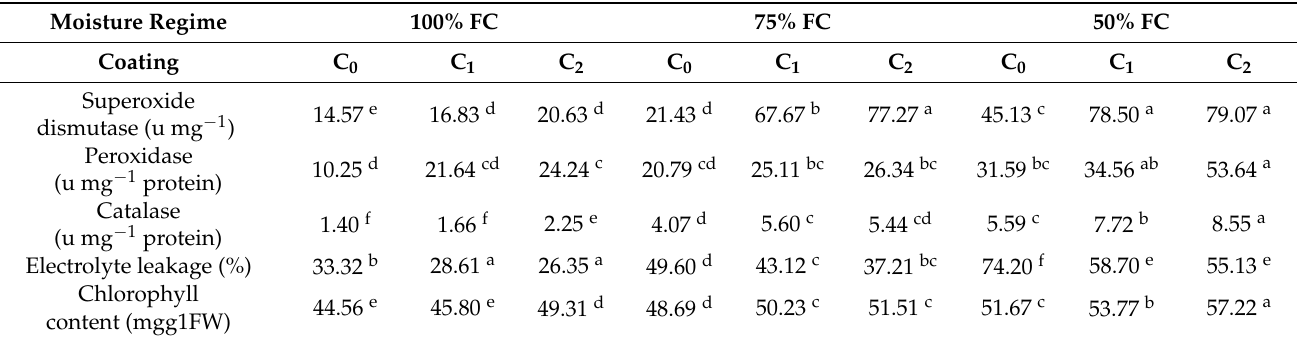
Table 10. Effect of moisture regime and organic coating on enzymatic antioxidant, electrolyte leakage, and chlorophyll content.